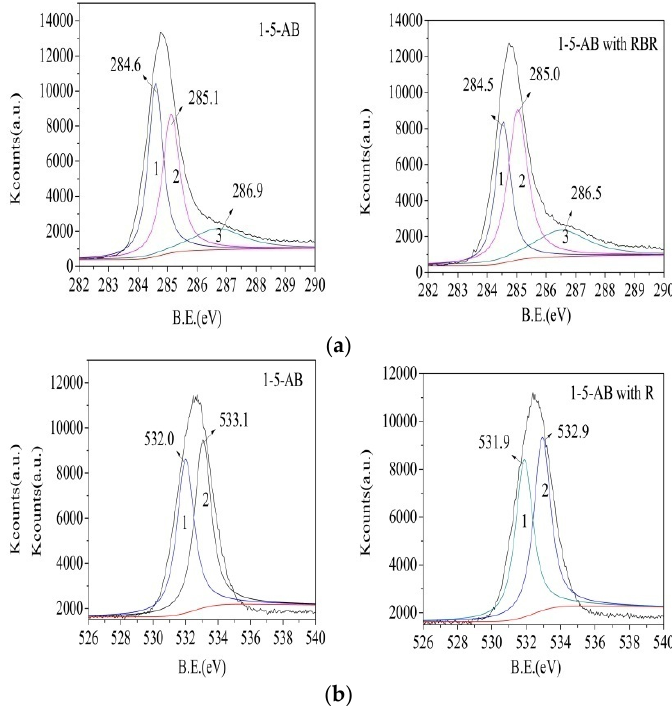
Figure 10. XPS spectra of C 1s ( a ) and O 1s ( b ) of 1 ‐ 5 ‐ AB before and after adsorption of RBR.